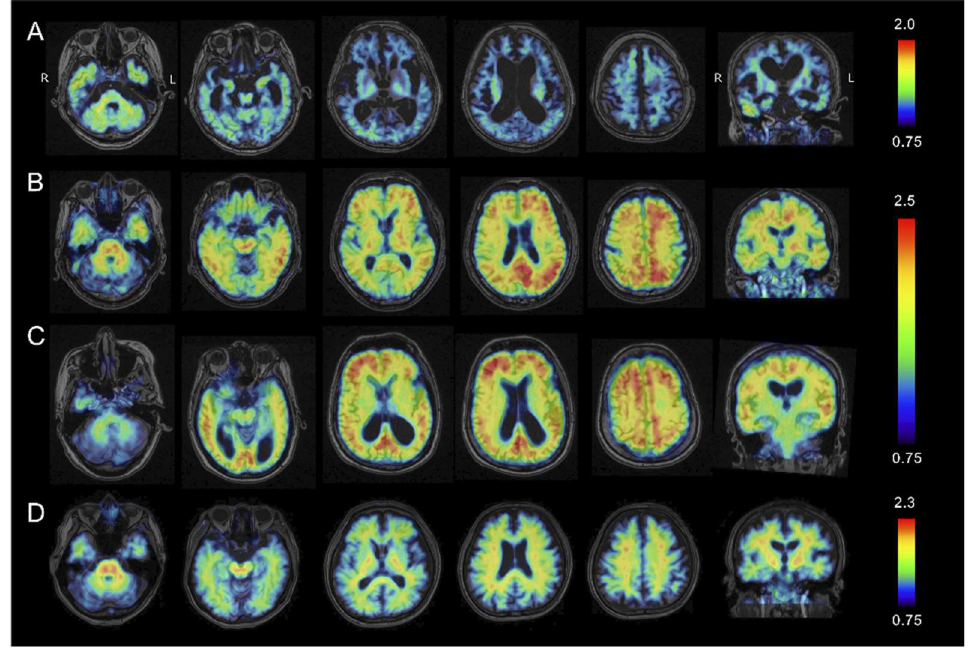
Figure 4. Amyloid PET using PiB in a patient with familial Alzheimer’s disease with Osaka mutation (FAD (Osaka)) ( A ); a patient with early sporadic Alzheimer’s disease (SAD) ( B ); a patient with advanced stage SAD ( C ); and a healthy control (HC) ( D ). Heat map range (colored bar) of amyloid tracer uptake defined by standard uptake value ratio (SUVR) with reference in the cerebellum. In the FAD (Osaka) patient, only negligible amounts of PiB retention were detected in any part of the cerebral cortex. Both the early and advanced SAD patients had highly elevated PiB uptake in the frontal, parietal and lateral cortices. No elevation in PiB accumulation was found in the HC.